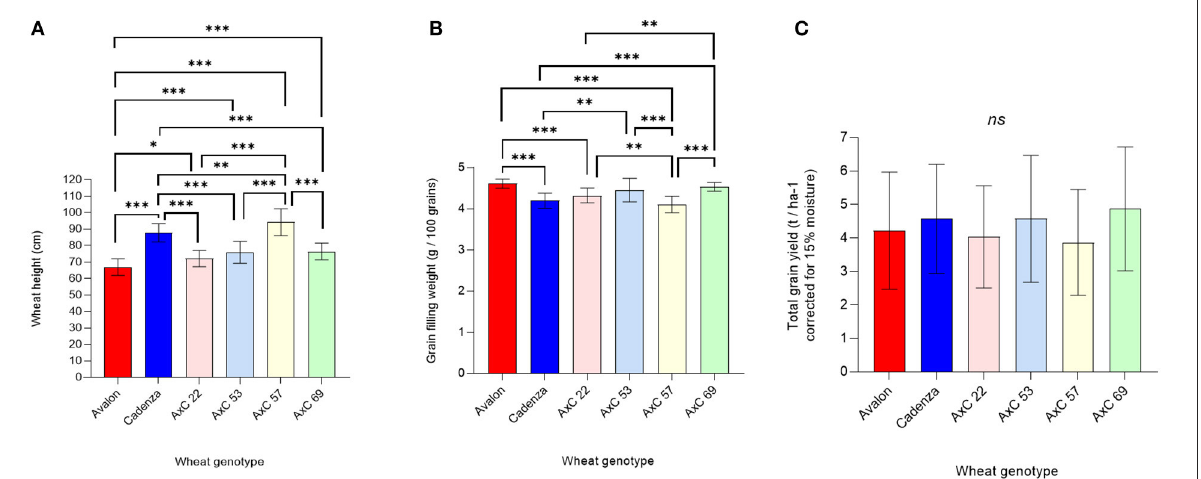
FIGURE6 Genotype effects of wheat lines Avalon, Cadenza, AxC22, AxC53, AxC57, and AxC69 on wheat performance, averaging across mycorrhiza, tillage and ley / arable treatments on (A) wheat tiller height (cm) (Avalon n = 29, Cadenza n = 29, AXC22 n = 21, AXC53 n = 22, AXC57 n = 20, and AXC69 n = 21), (B) grain weight (g / 100 grains) (Avalon n = 20, Cadenza n = 20, AXC22 n = 20, AXC53 n = 20, AXC57 n = 20, and AXC69 n = 20), and (C) total grain yield (corrected for 15% moisture, t ha − 1 ) (Avalon n = 29, Cadenza n = 29, AXC22 n = 21, AXC53 n = 22, AXC57 n = 20, and AXC69 n = 21). The error bars show ± 1 SE. Results of significant Tukey’s HSD test results of significant differences are shown on the graphs (* p = 0.05; ** p = 0.001; *** p < 0.0001